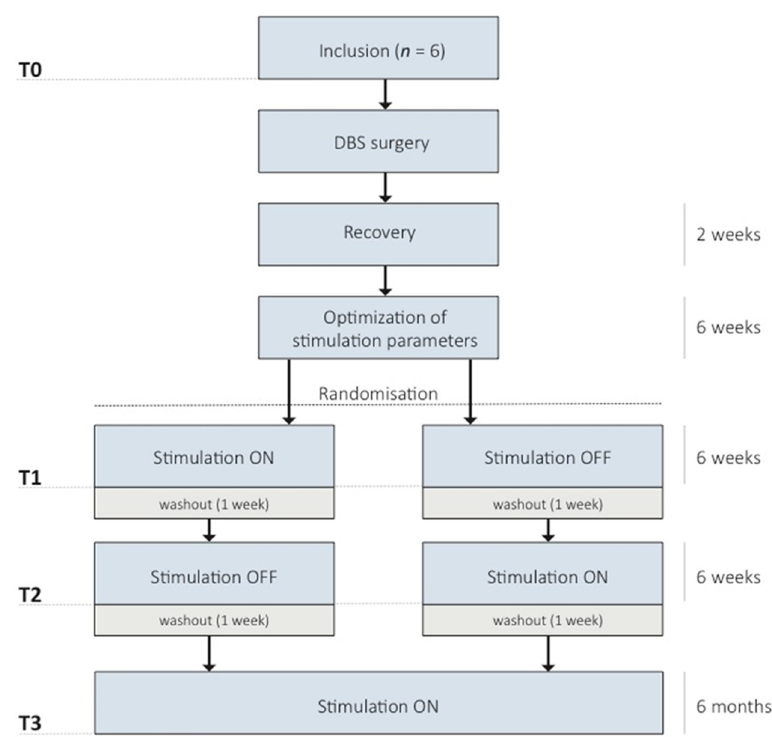
Figure 1. Overview of study design.